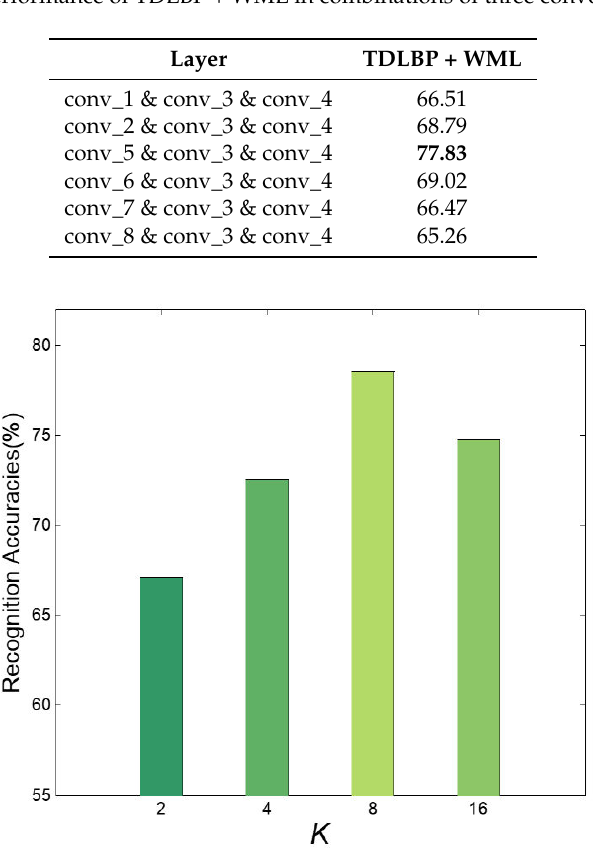
Table 10. The performance of TDLBP + WML in combinations of three convolutional layers.